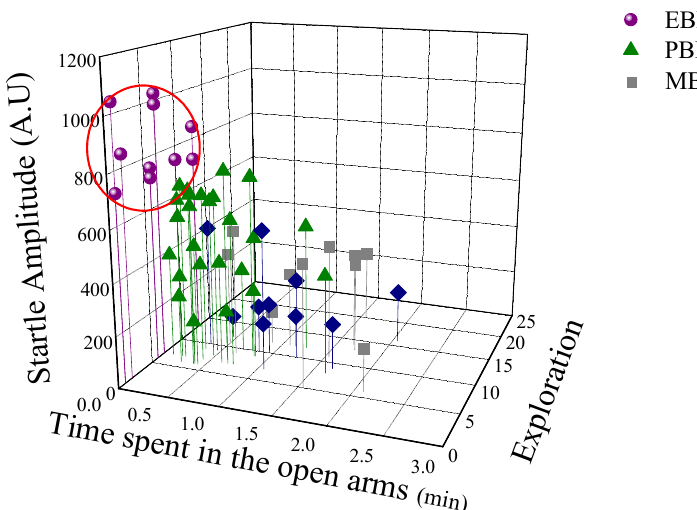
Figure 2. The effect of the predator scent stress (PSS) paradigm on overall anxiety-like behavior and startle response: Three-dimensional parameters: The X-axis represents time spent in the open arms (min), the Y-axis represents acoustic startle amplitude, and the Z-axis—total exploration on the maze. The stress response was not homogeneous, and several subgroups were identifiable in the population. Circles (purple) represent the exposed group that exhibited a significant degree of anxiety-like and avoidant behaviors on the elevated plus-maze and a pattern of exaggerated startle responses with significantly reduced habituation 7 days after exposure (PTSD-like phenotype). Triangles (green) represent the exposed group that exhibited partial behavioral response patterns. Squares (gray) represent the exposed group that exhibited minimal behavioral disrupted. Diamonds (blue) represent the un-exposed control group.